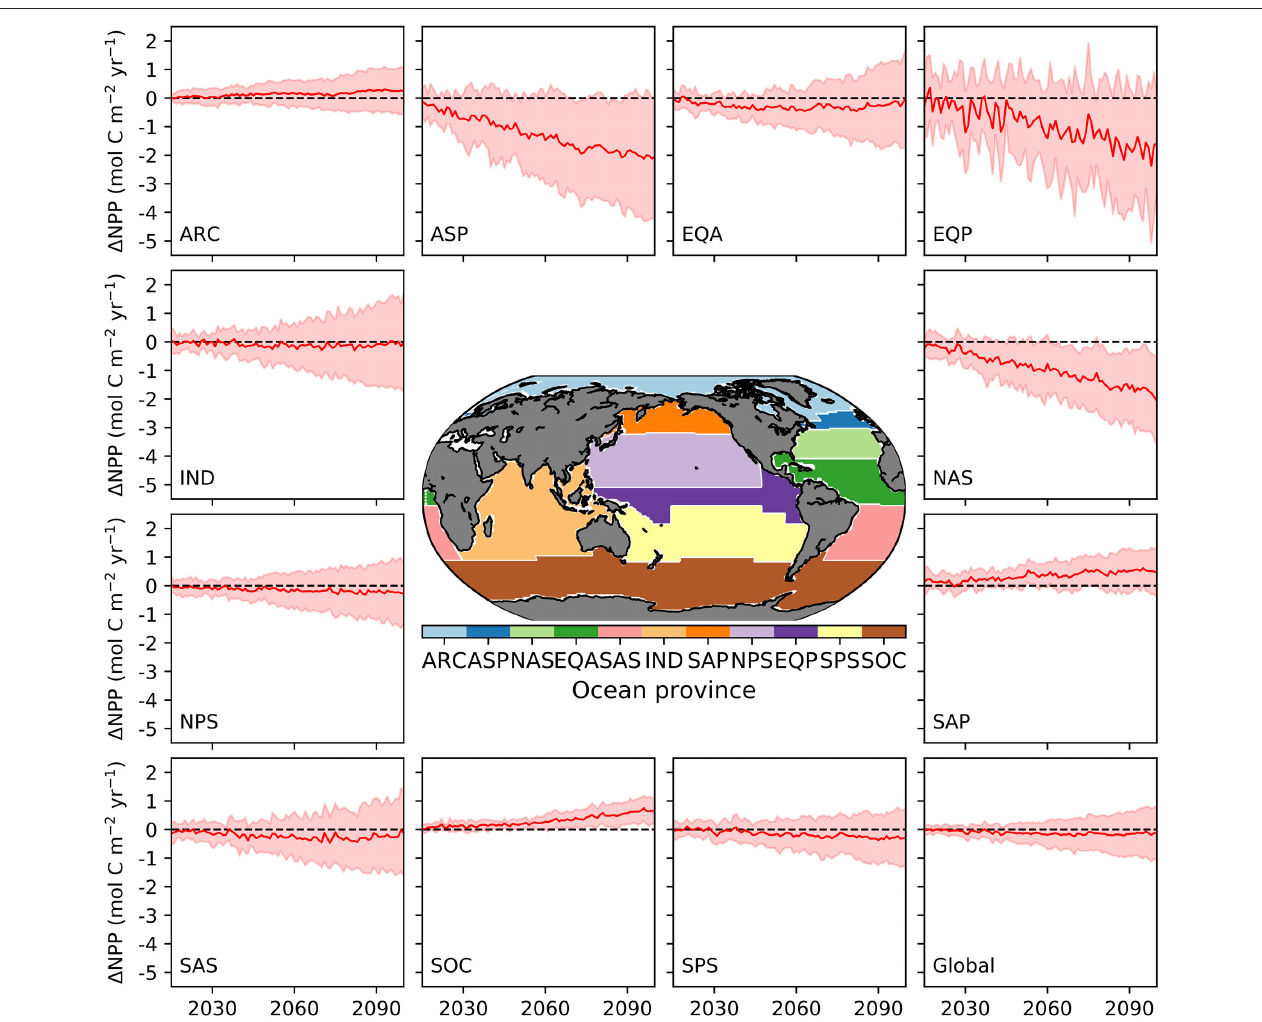
FIGURE 5 | Absolute change in annual NPP (relative to 1995–2014) in mol C m − 2 across different biogeochemical provinces and globally from 16 CMIP6 models. The red line represents the multi-model mean and the shaded area the 1 σ “likely” uncertainty range. The map shows the location of the